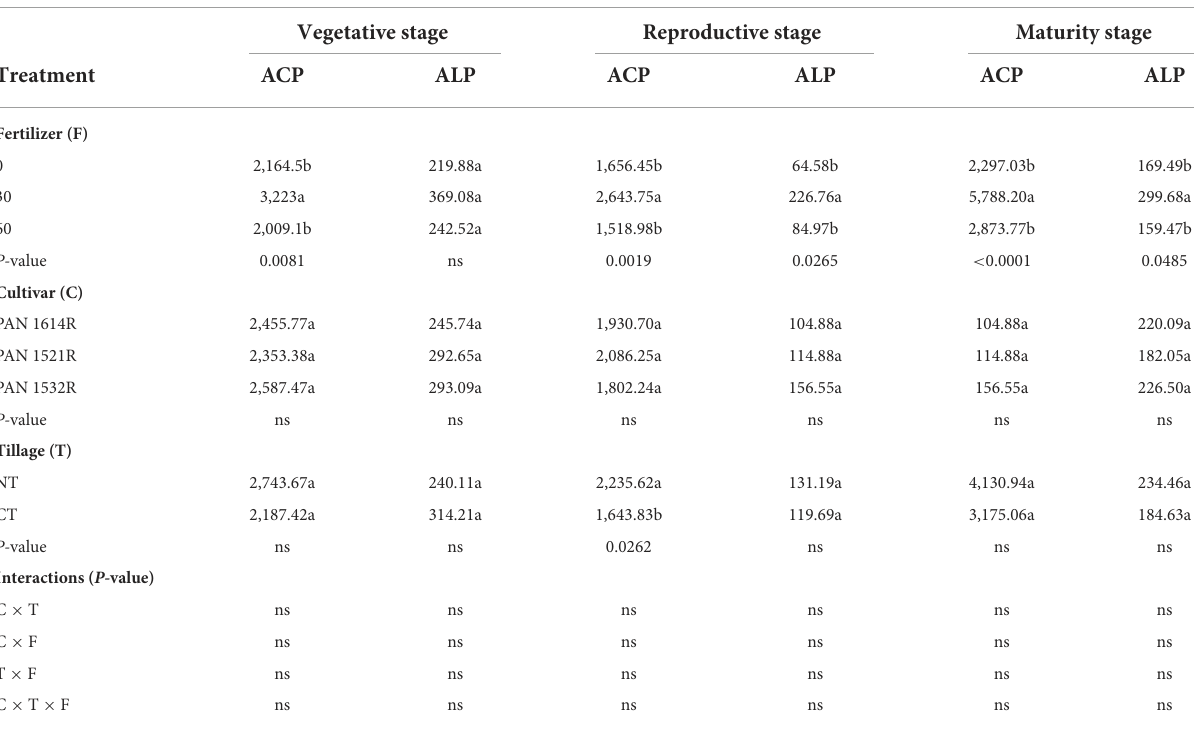
TABLE 3 Fertilizer application, cultivar and tillage effects on acid phosphatase and alkaline phosphatase activities on a soybean cropping